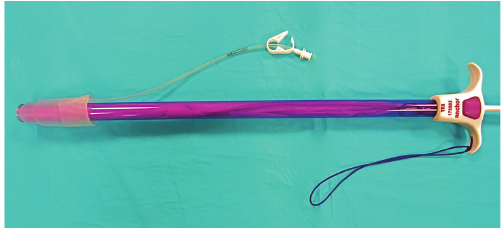
Figure 3: 60 cc syringe used to expand pneumo-occluder.